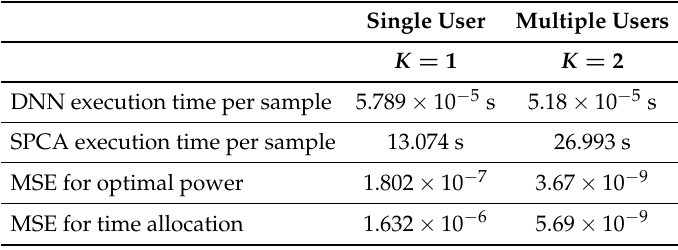
Table 1. Performance evaluation for the deep neural network (DNN) and SPCA method. MSE: mean squared